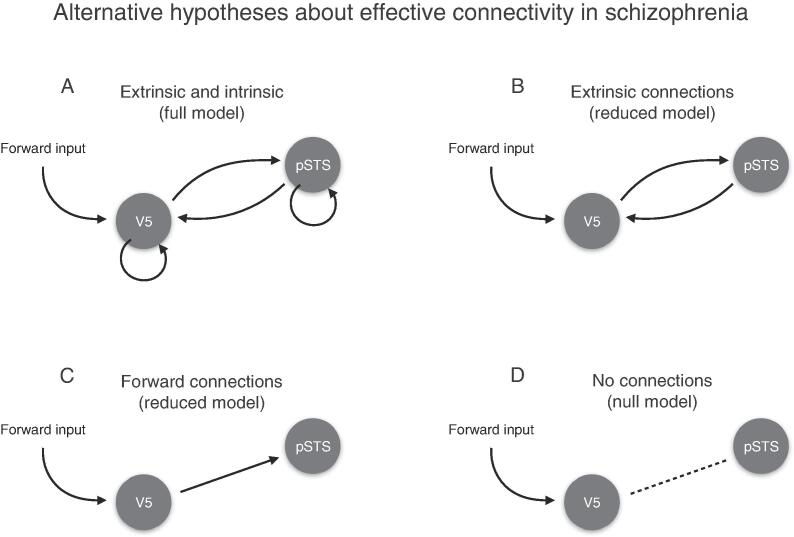
Alternative hypotheses about effective connectivity in patients with first-episode schizophrenia (A) Full model with free parameters on extrinsic and intrinsic connections (B) Reduced model with free parameters on extrinsic connections (C) Reduced model with a free parameter the on feedforwards connection only (D) Null model with no connections between V5 and pSTS.